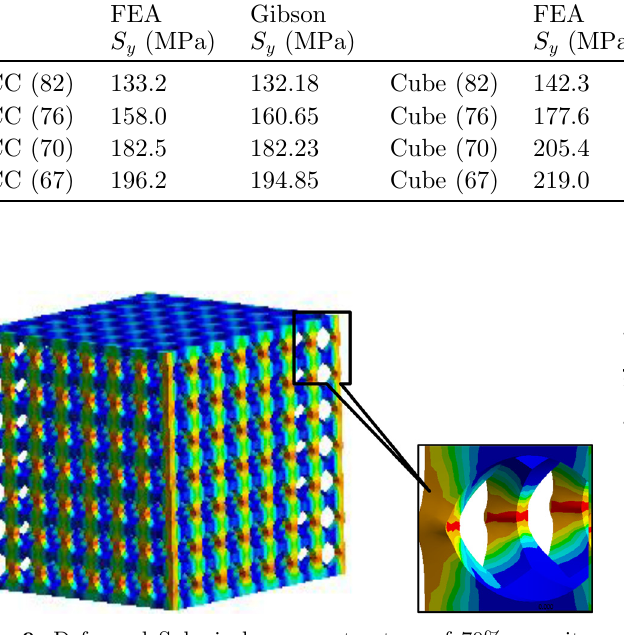
Fig. 9. Deformed Spherical porous structure of 70% porosity (similar behavior also observed for 67% porosity).